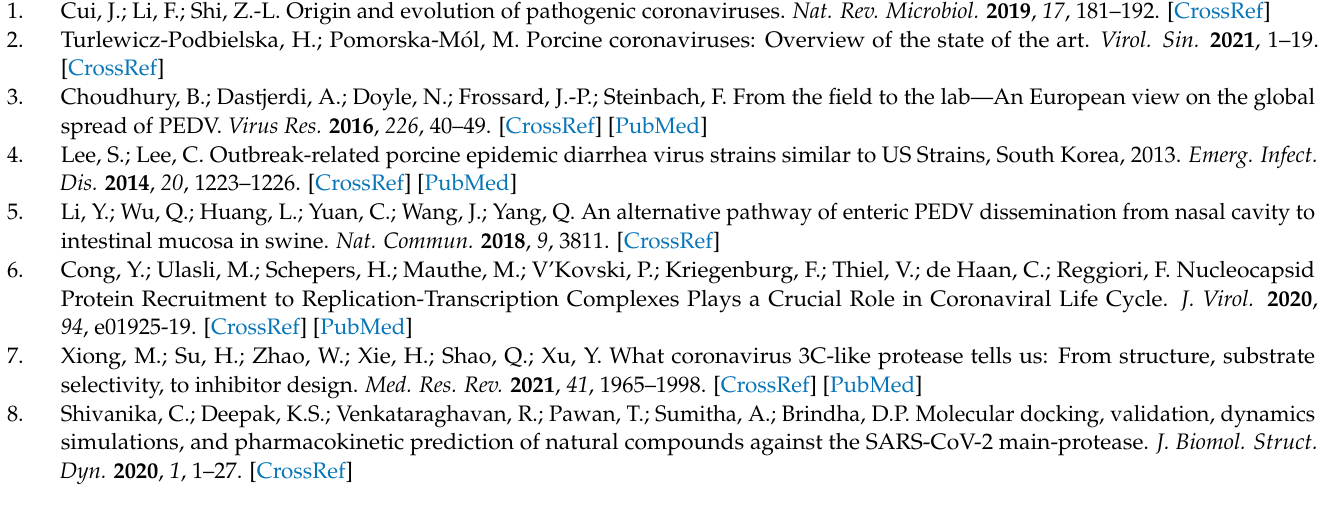
1 showing hypericin docked onto 3CLpro dimer with binding affinities of − 10.4 kcal/mol. ( B ) The overview of solution 2 showing hypericin docked onto 3CLpro dimer (left) or monomer (right) with binding affinities of − 9.2 kcal/mol. ( C , D ) The hydrogen bond interactions of hypericin with ( C ) Met6, Ile151, Asn152, Asn153, and Gln295 in dimer and ( D ) Asn141, Glu165, Glu185, Asp186, Gln187, and Gln191 in monomer. ( E ) Hydrophobic interaction of Met6, Ala122, and Ile151 in the dimer with hypericin. ( F ) Hydrophobic interaction of Met25, Ile51, Leu164, and Leu166 with hypericin in the monomer. Hypericin is shown as yellow ligand, and hydrogen bond is indicated as red dashed lines. Figure S3: Molecular docking results of hypericin onto TGEV 3CLpro. The docking results were visualized by using PyMOL. ( A ) The overview of solution 1 showing hypericin docked onto 3CLpro dimer with binding affinities of − 10.15 kcal/mol. ( B ) The overview of solution 2 showing hypericin docked onto 3CLpro dimer (left) or monomer (right) with binding affinities of − 10.17 kcal/mol. ( C , D ) The hydrogen bond interactions of hypericin with ( C ) Ser110, Phe111, Gly122, Leu151, and Glu152 in dimer, and ( D ) Thr47, Thr48, Glu165, Gly167, Gln187, and Gln191 in monomer. ( E ) Hydrophobic interaction of Met6, Ala7, Phe111, Val150, and Leu151 in the dimer with hypericin. ( F ) Hydrophobic interaction of Leu164, Leu166, and Met190 with hypericin in the monomer. Hypericin is shown as yellow ligand, and hydrogen bond is indicated as red dashed lines. Table S1. Protein identity of PEDV with TGEV, HCoV-229E, and